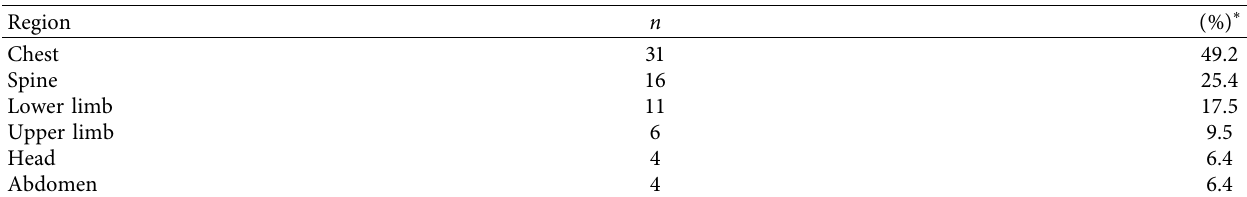
Table 4: Concomitantly injured body regions other than the sternum.